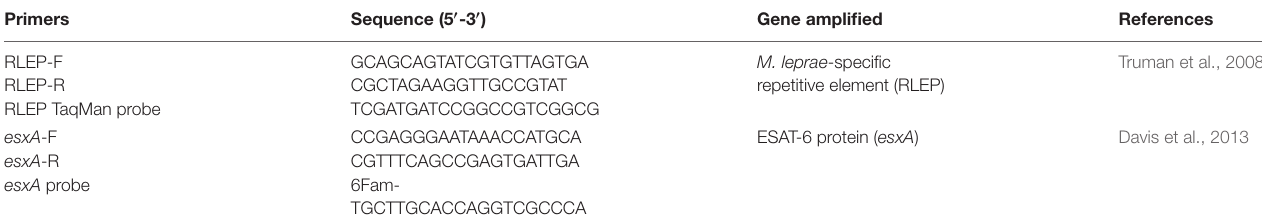
TABLE 1 | List of primers, sequences, and references used in this study. Primers Sequence (5 (cid:48) -3 (cid:48) ) Gene